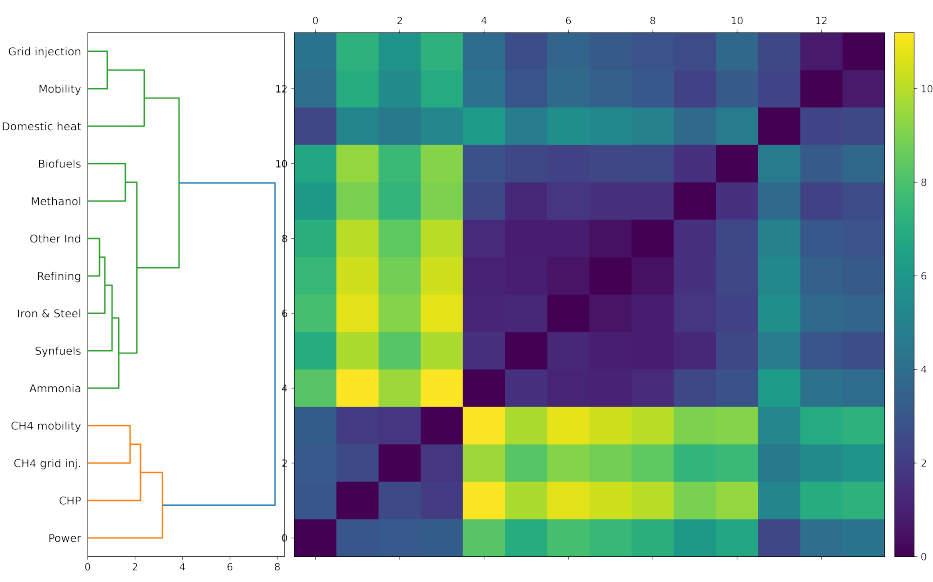
Figure 2. Hierarchical clustering on cumulative distribution functions F S (relative to time) for all 14 end-use sectors S in our database. A strong cluster of similarity is observed for the seven industrial uses, ranging from biofuels to ammonia. A secondary cluster of more ‘consumer uses’ is revealed from grid injection to domestic heat, whereas power is observed as an outlier due to its highly uniform